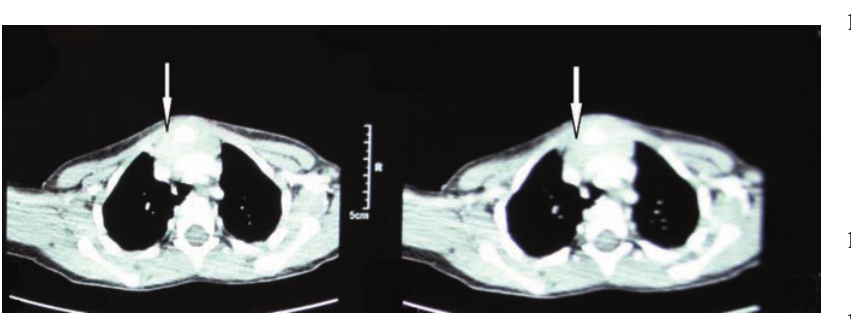
Figure 2. Axial contrast-enhanced computed tomography showing that the mass is reduc- ing around